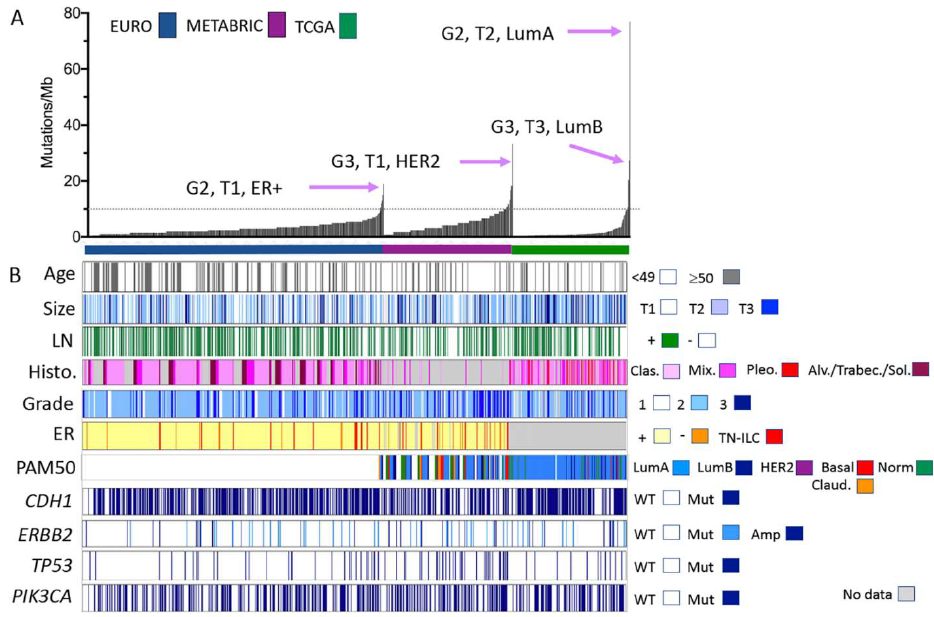
Figure 1. Clinical, morphological, and molecular characteristics of ILC cohorts analysed by gene panel and exome sequencing. ( A ) Individual ILC from three separate cohorts are ordered along the x -axis by increasing the mutation burden ( y -axis, calculated according to the number of mutations detected per Mb of the genome sequenced). Tumour features (grade, size, and tumour phenotype) of those ILC with the highest mutation burden in each cohort are highlighted. ( B ) Clinical and pathological features of the tumours sequenced and mutations detected in common driver genes in ILC. Size: <2 cm = T1; 2–5 cm = T2; >5 cm = T3. Abbreviations: Alv = alveolar; Amp = amplified; Clas. = classic; ER = oestrogen receptor status; LN = lymph node; Mix. = mixed and other variants; Mut = mutated; TN-ILC = triple negative ILC; Sol. = solid; Trabec = trabecular; WT = wild type; G2 = grade 2; G3 = grade 3; LumA/LumB = Luminal A/B phenotype; and Claud. = claudin-low.